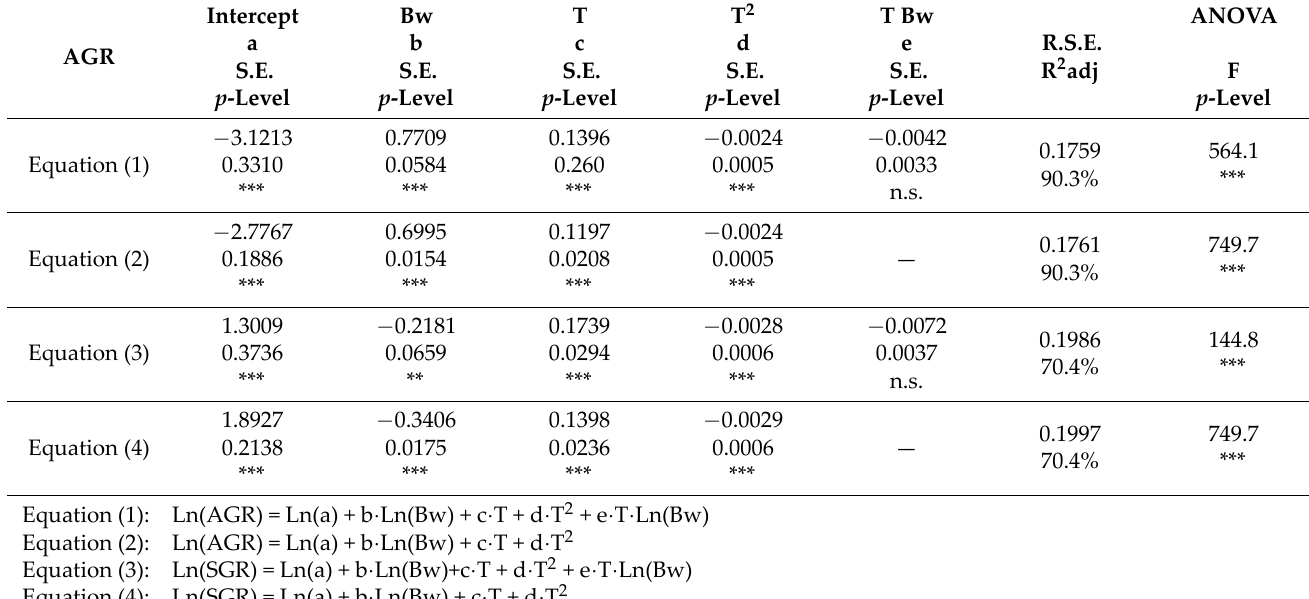
Table 2. Multiple regression analysis results for AGR and SGR as dependent variables from Bw values less than 400 mg. S.E., standard error; R.S.E., residual standard error; and R 2 adj, adjusted coefficient of